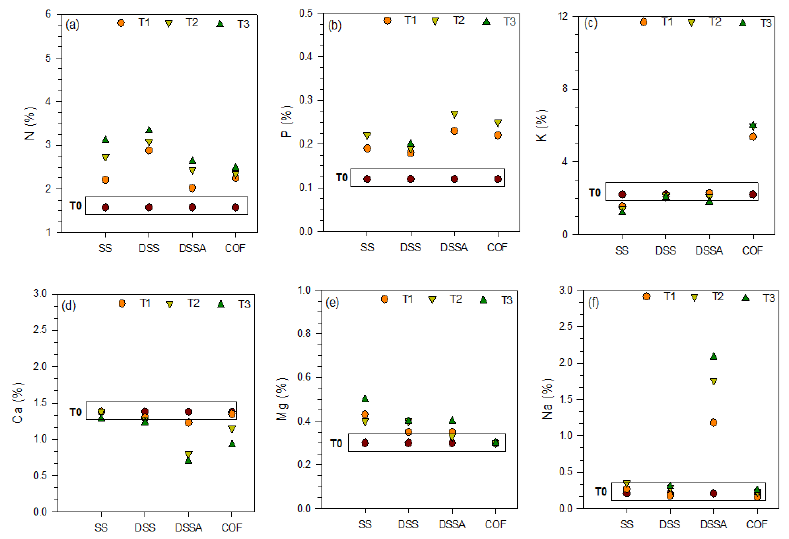
Figure 3. Macronutrient content ( a ) nitrogen; ( b ) phosphorus; ( c ) potassium; ( d ) calcium; ( e ) mag- nesium; ( f ) sodium in the dried biomass of lettuce for the different added soil amendments (T0—0 kg N/ha; T1—85 kg N/ha; T2—170 kg N/ha; T3—255 kg N/ha; mean values obtained in four repli- cates of each treatment).